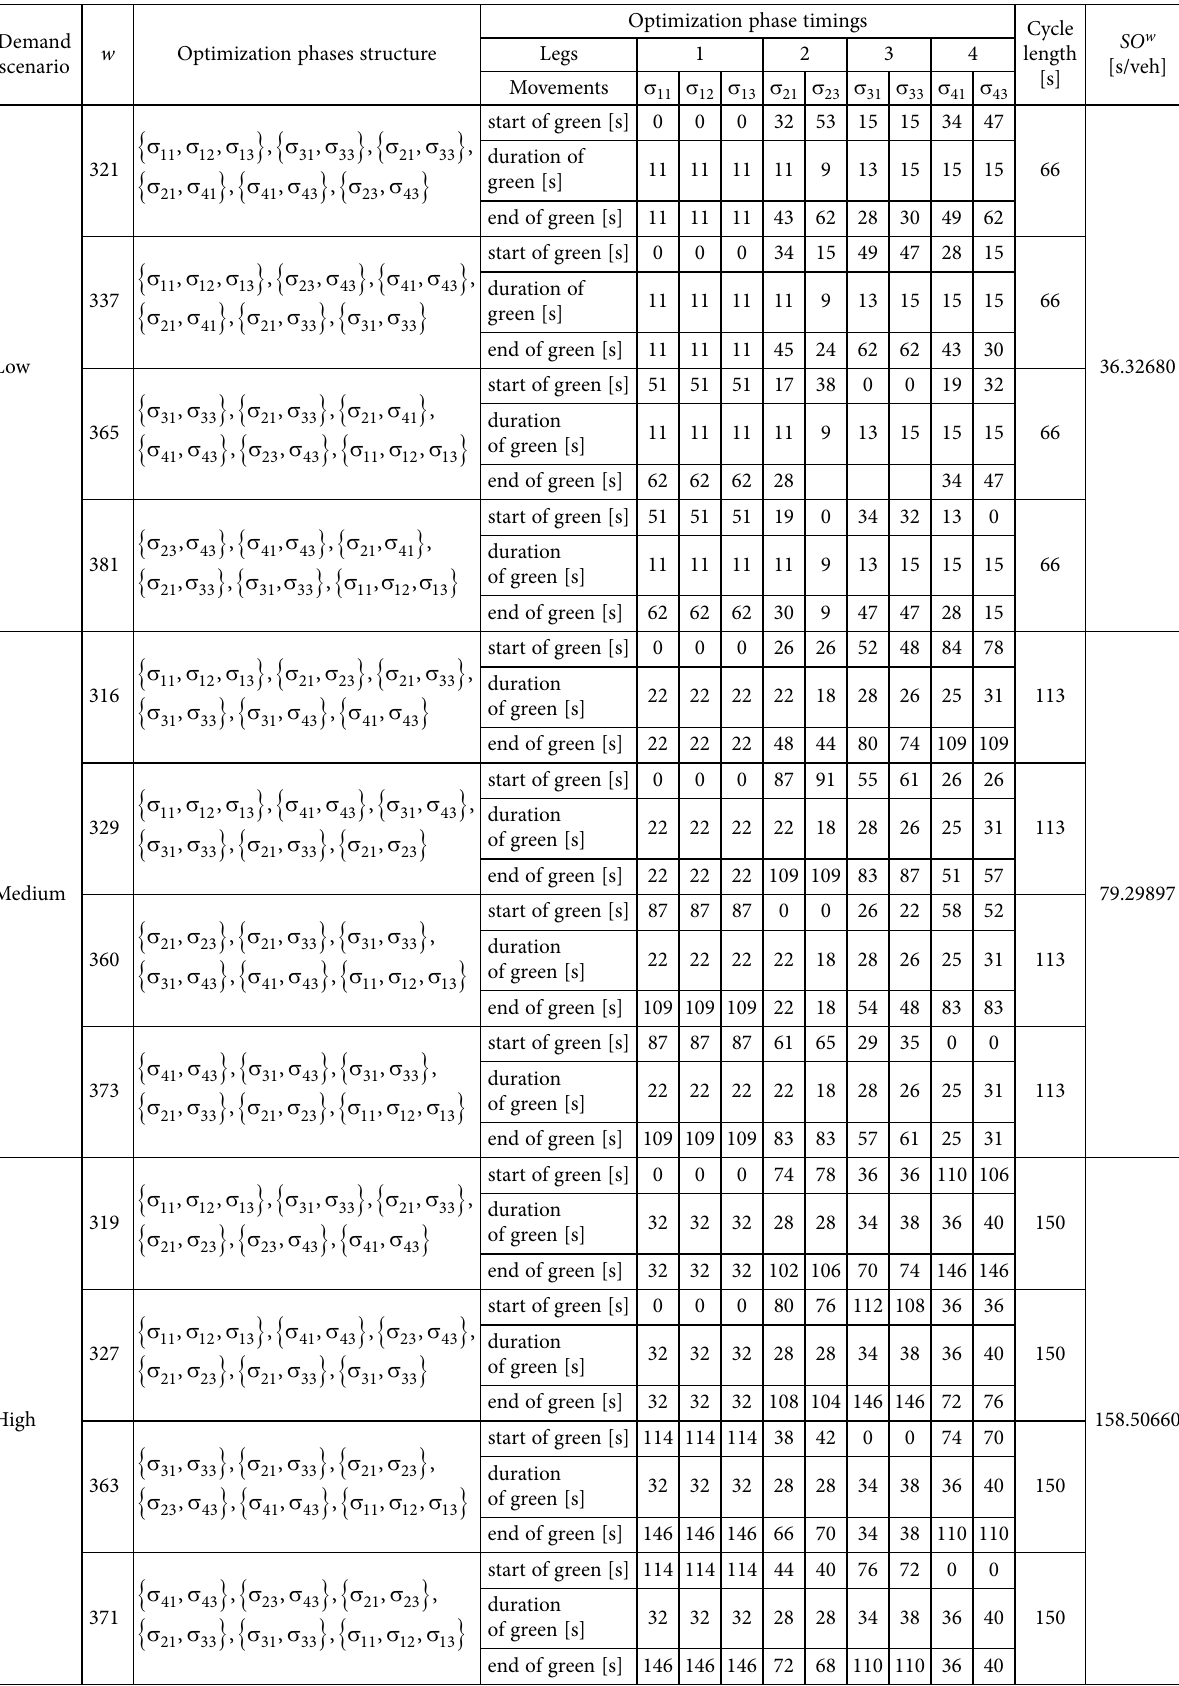
Table 7. Optimization results of signal